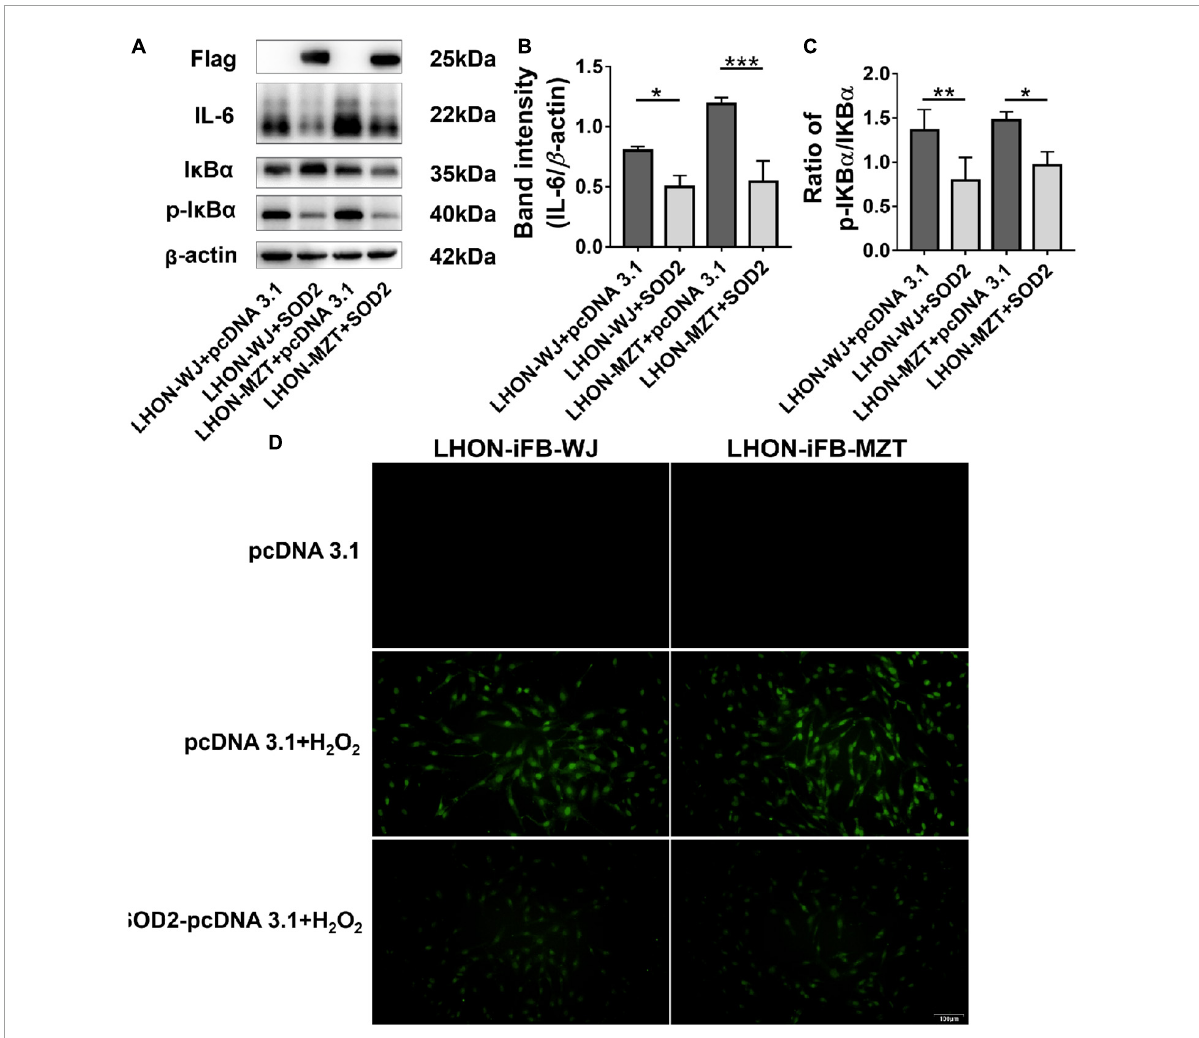
FIGURE4 Protective effects of SOD2 on inflammatory response and apoptosis in LHON-iFBs. Western blot showed that (A,B) protein levels of IL-6 and (A,C) the ratio of p-I κ B α to I κ B α were inhibited by SOD2 significantly in LHON-iFBs transfected with SOD2 plasmid. (D) TUNEL staining demonstrated cell apoptosis in LHON-iFBs transfected with SOD2 plasmid or negative control plasmid for 48 h, respectively, before exposure to hydrogen peroxide for 12 h. The results (mean ± SD) were statistically significant (* p < 0.05, ** p < 0.01, *** p < 0.001, n = 3–4) by using one-way ANOVA with Bonferroni correction, and the assays were performed three